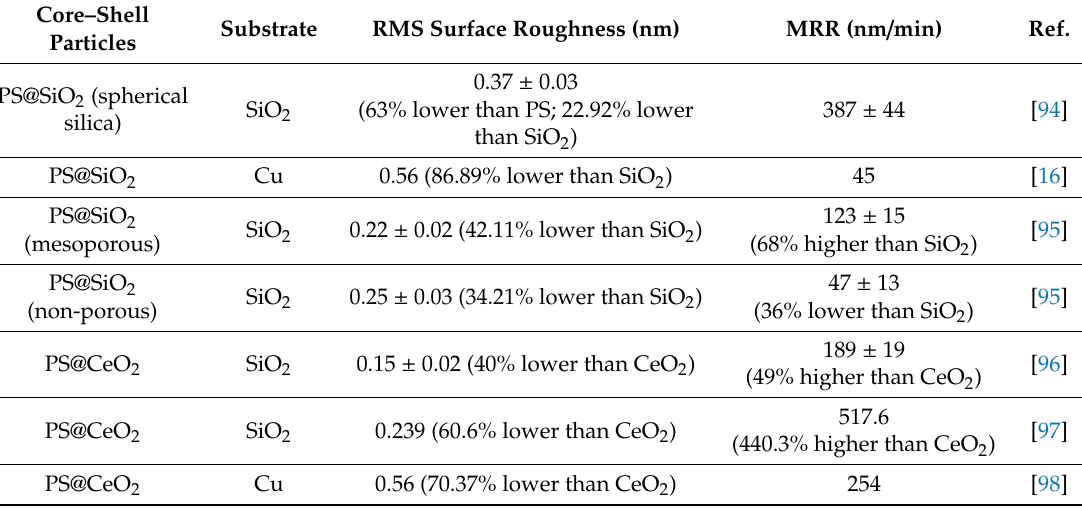
Table 4. Parameters of composite abrasives in chemical mechanical polishing.